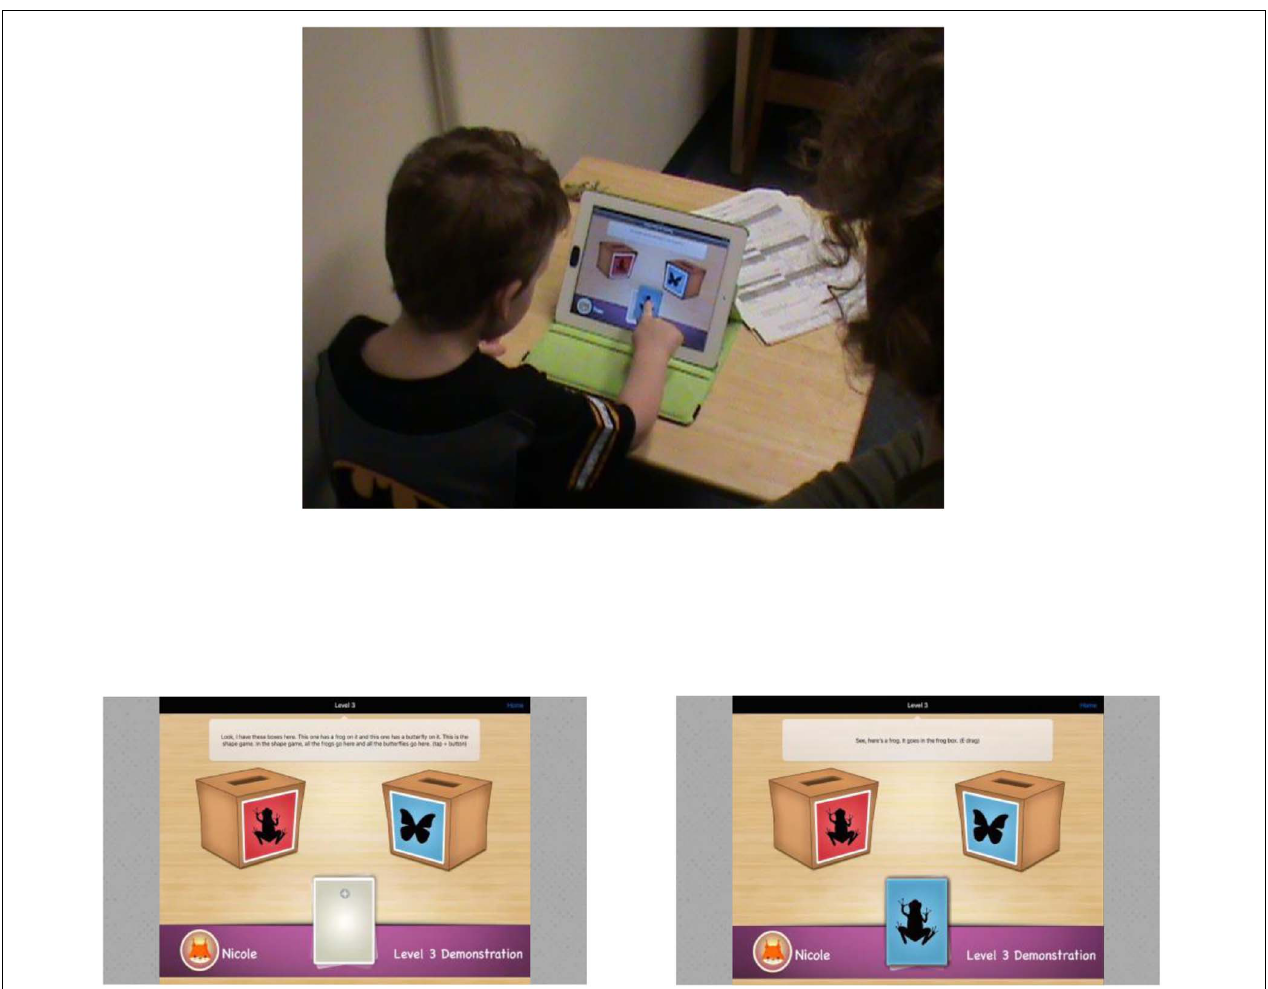
FIGURE 3 | A 3-year-old boy completes a version of the Minnesota Executive Function Scale. Images show the Minnesota Executive Function Scale by Carlson and Zelazo (2014), Saint Paul, MN: Reflection Sciences, LLC. Copyright 2014 by Reflection Sciences, LLC. Reprinted with